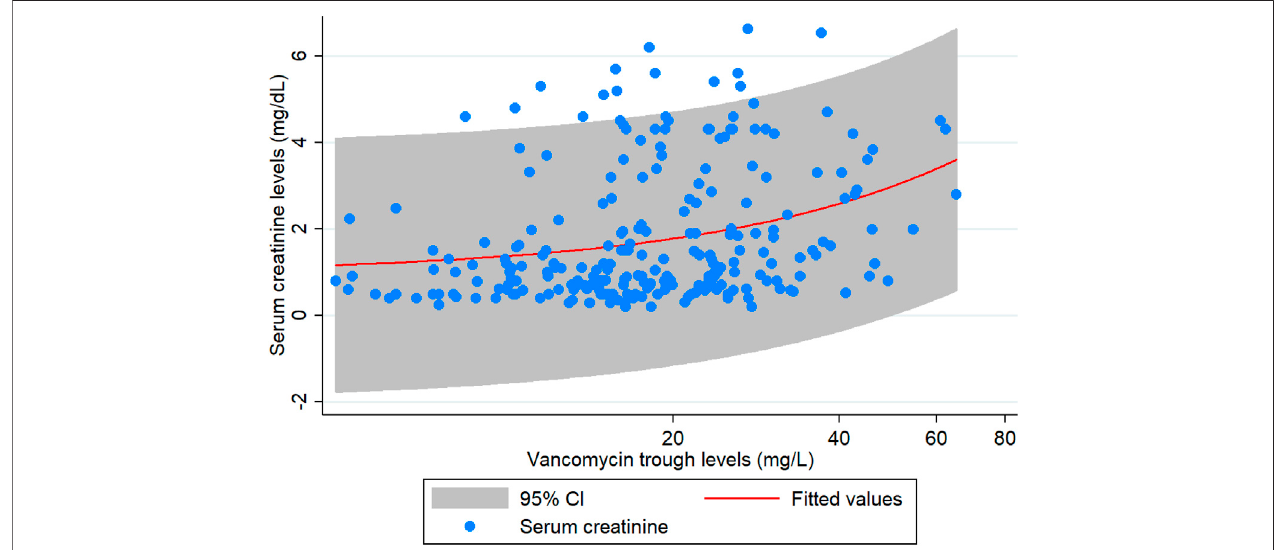
FIGURE 4 | The association between vancomycin trough concentrations and increased serum creatinine.